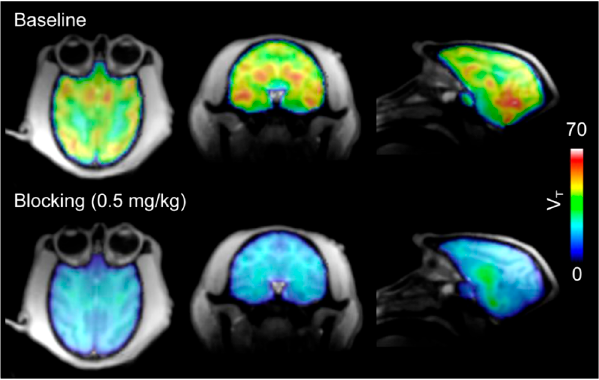
Figure 3. The total volume of distribution ( V T ) images from [ 11 C] 8 PET in baboon brains. Robust brain uptake ( top ) of [ 11 C] 8 was decreased by pre-treatment with unlabeled 8 ( bottom ). (Reproduced from Wang et al. J Med Chem; published by The American Chemical Society, 2014 [68]).